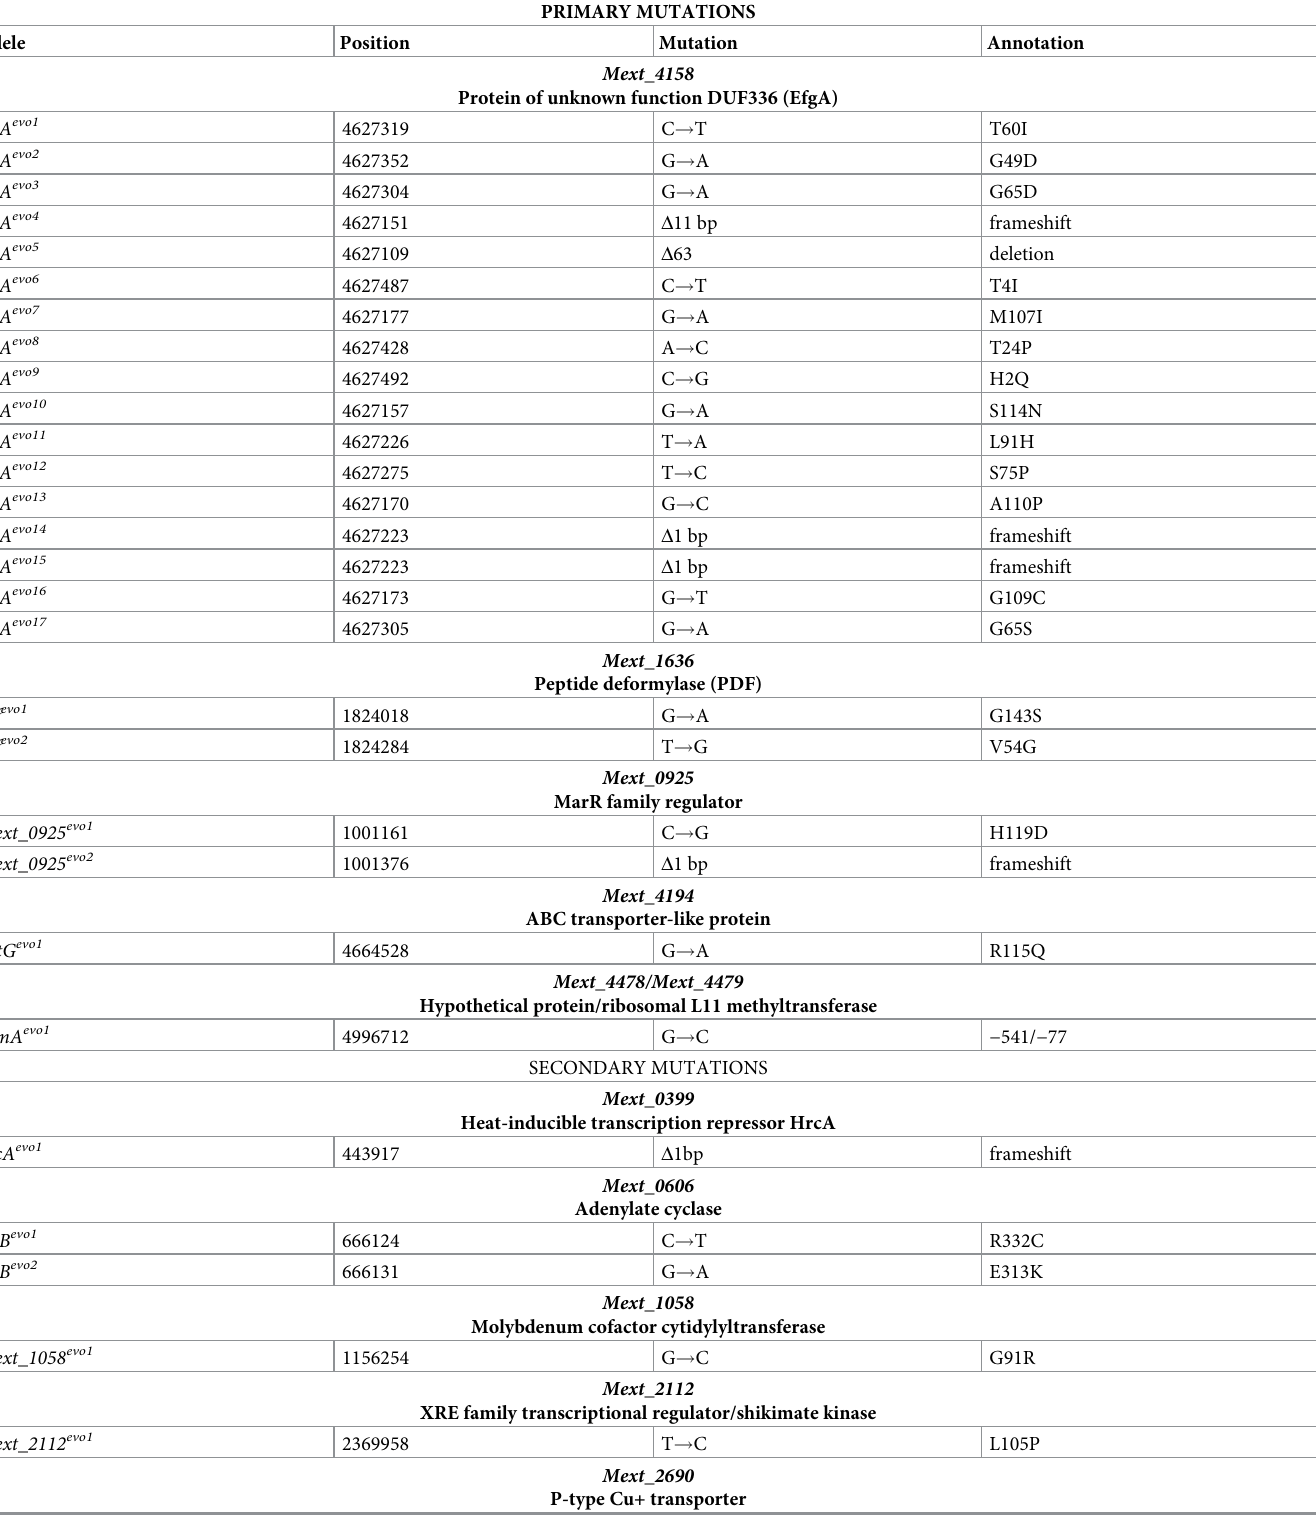
Table 1. Evolved beneficial